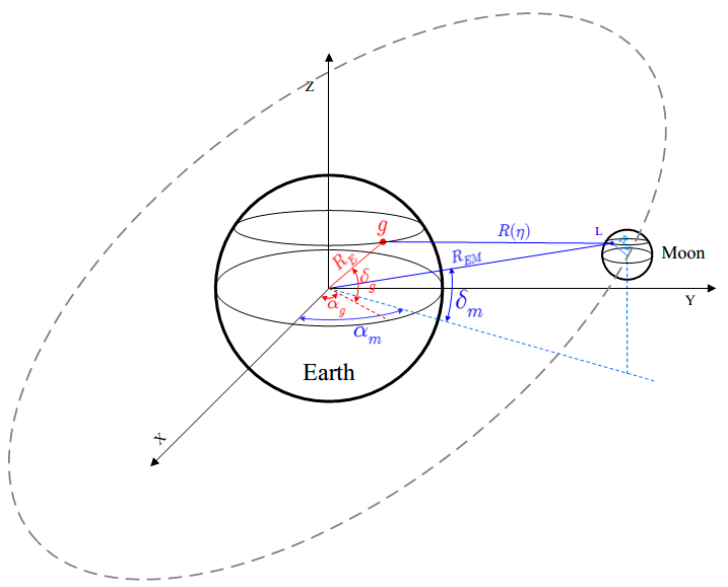
Figure 1. An unified right-handed geocentric inertial reference coordinate system for Moon-Based synthetic aperture radar (SAR), where point g represents the ground target, R EM is the distance between the Earth and the Moon-Based SAR, which can be approximately regarded as the Earth and the Moon, and R E is the earth radius at point g. (not to scale for the sake of clarity).